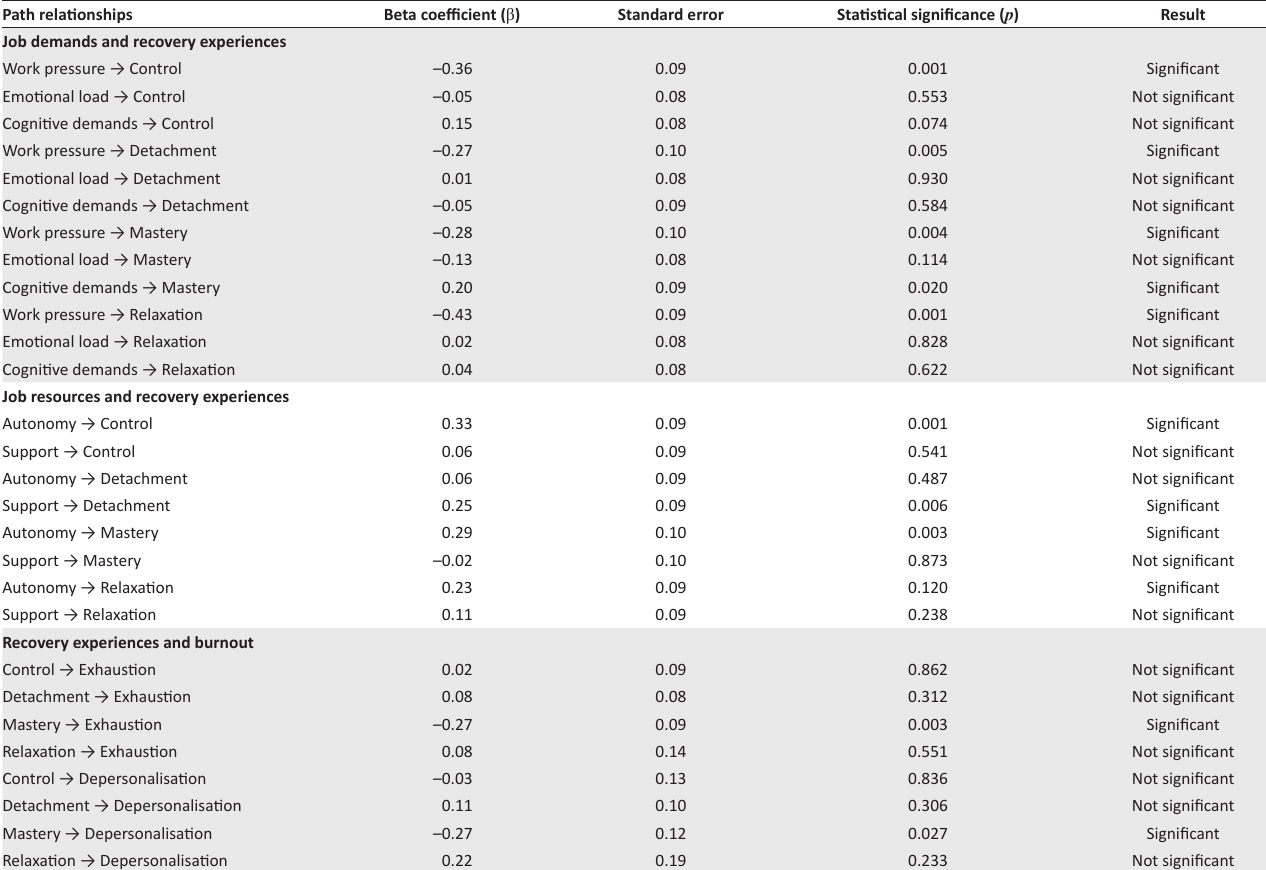
TABLE 3: Structural relationships between job characteristics and recovery experiences, and between recovery experiences and